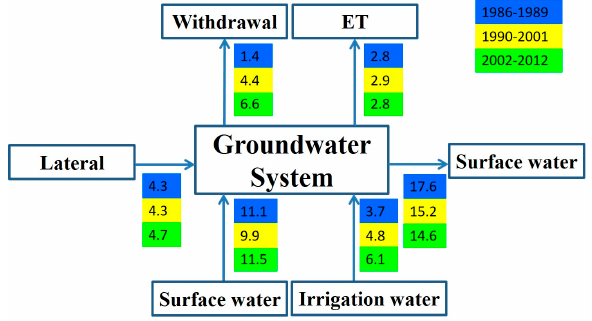
Figure 4. Water balance of the middle reaches of the HRB.